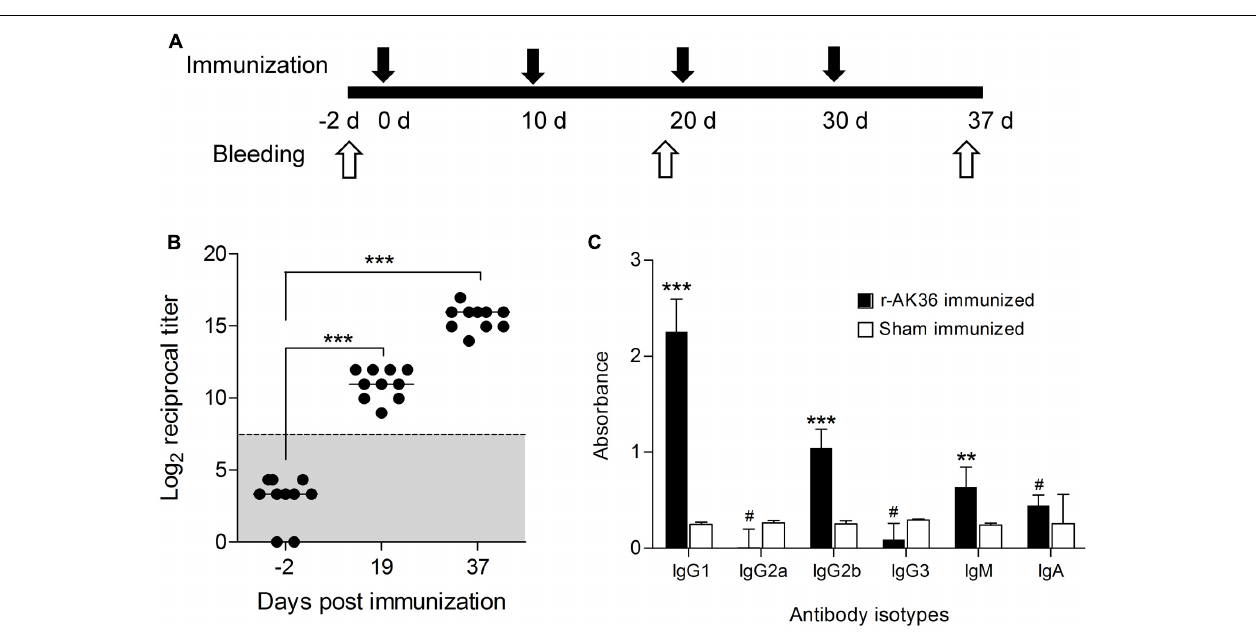
FIGURE 2 | Determination of antibody titers and antibody isotypes from r-AK36 evoked anti-r-AK36 serum in BALB/c mice. (A) Schematic representation of immunization and blood collection schedules of r-AK36 antigen. (B) Estimation of antibody titers of anti-r-AK36 serum induced by r-AK36 subunit vaccine at different time points of immunization. (C) Antibody isotypes induced by r-AK36 was evaluated by ELISA using isotype-specific monoclonal antibodies for IgG1, IgG2a, IgG2b, IgG3, IgM and IgA. Data are represented in mean ± SD ( n = 8).Significance ( P )-value summary analyzed by univariate ANOVA: ∗ P ≤ 0.05, ∗∗ P ≤ 0.01; ∗∗∗ P ≤ 0.001; no significance